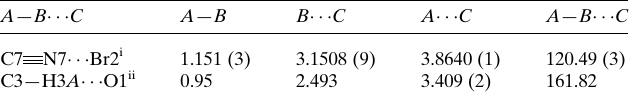
Table 1 Contact geometry (A˚ , (cid:4) )..